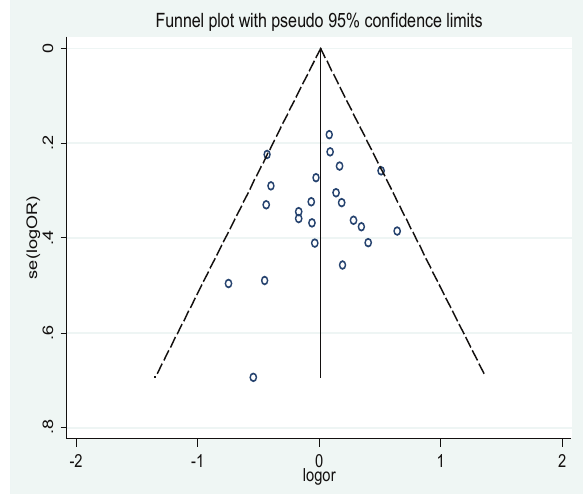
Figure 4: The Begg’s funnel plots showe no significant publication bias homozygous genetic model (GG vs AA).